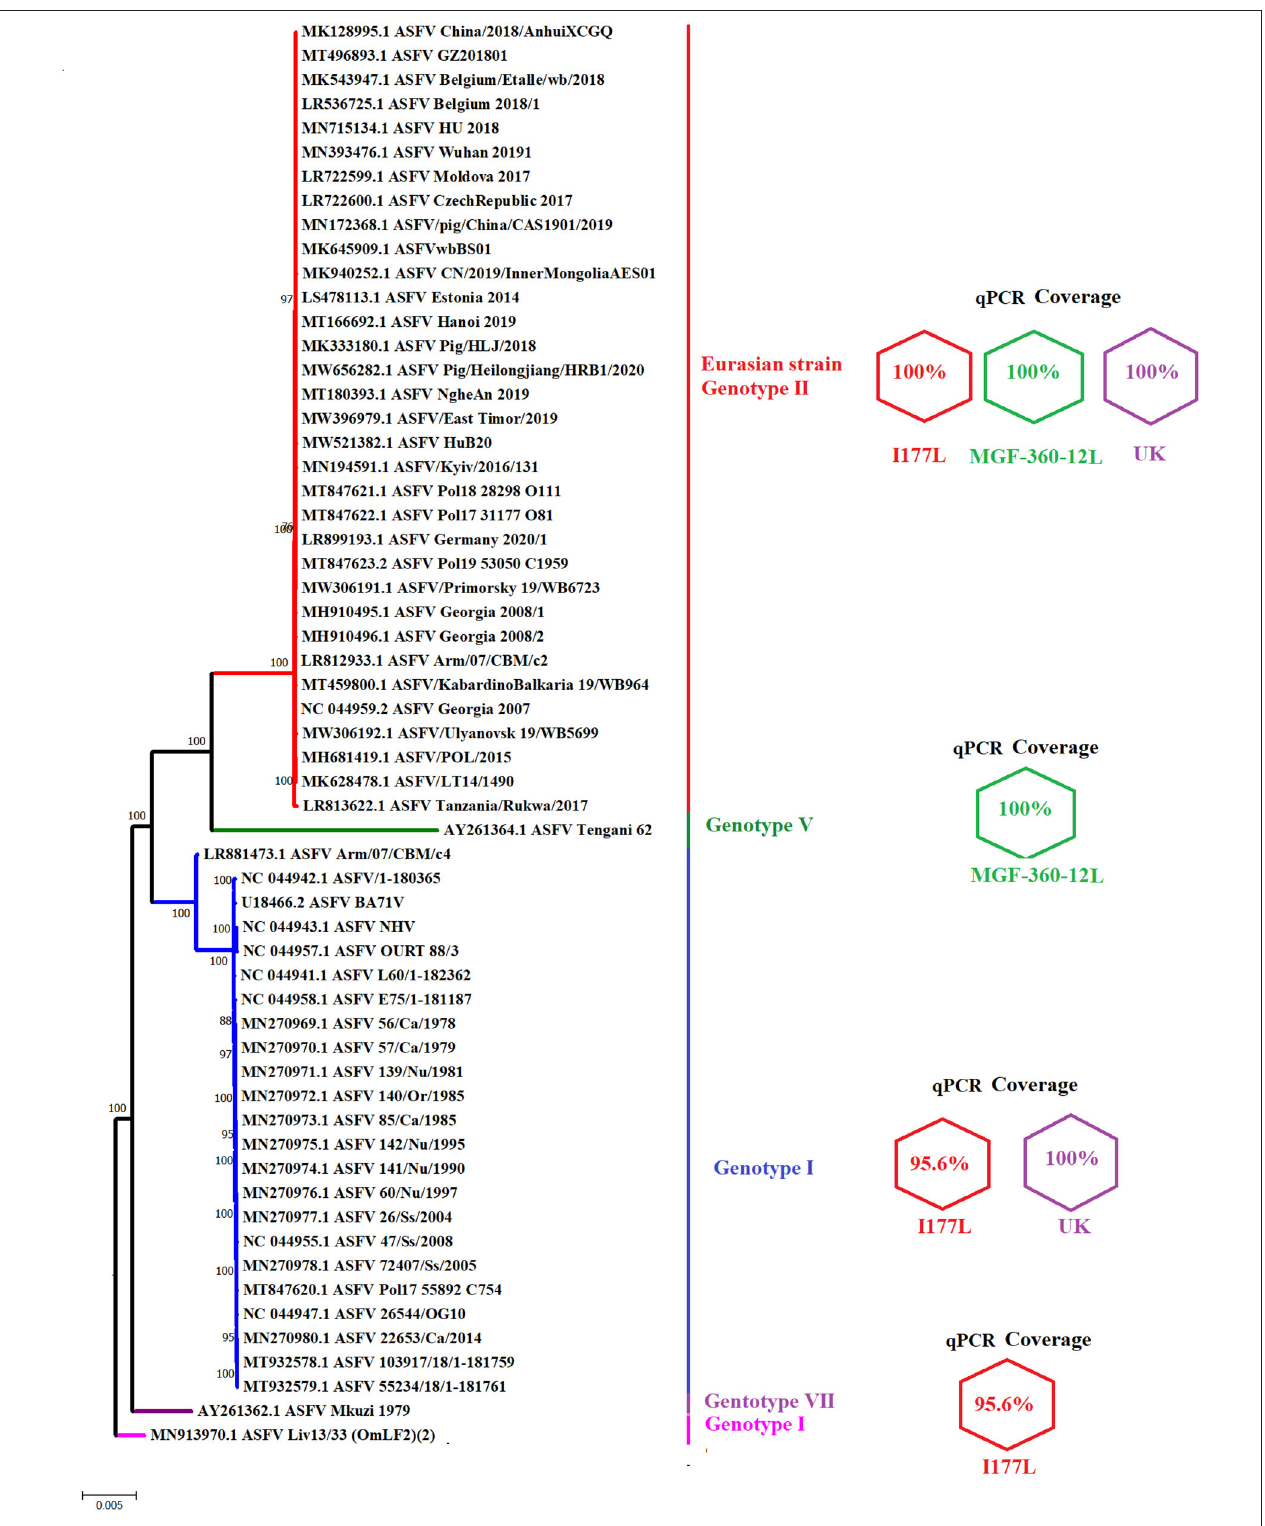
FIGURE 2 | Graphic representation of the genetic coverage of different qPCR tests. The figure shows a phylogenetic analysis reconstructed by neighbor-joining using full-length sequences of multiple ASFV strains which may be potentially detected by different qPCRs designed in this study. Next to each clade representing multiple genotypes are expressed the identity of different primers and probes included in each qPCR. Values of 100% indicate no differences between viral sequences and different oligonucleotides. A value of 95.65%, for one I177L real-time PCR primer, is due to the presence of one mismatch between the forward primer and sequences of different genotypes. Numbers along the branches represent the bootstrap support